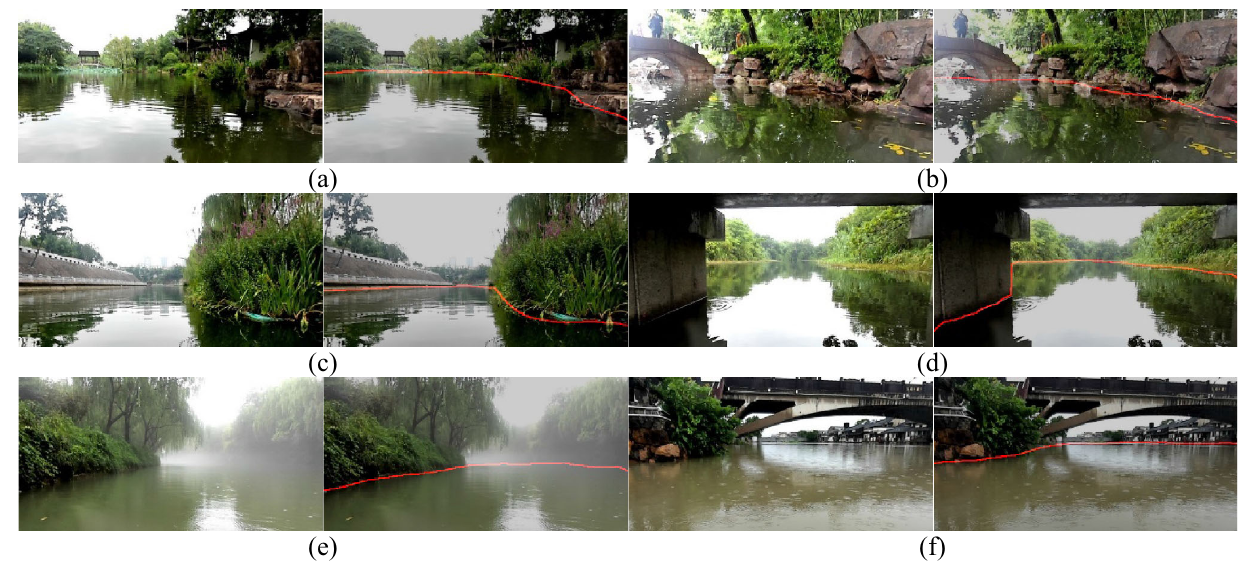
Fig. 13 The water shoreline detection